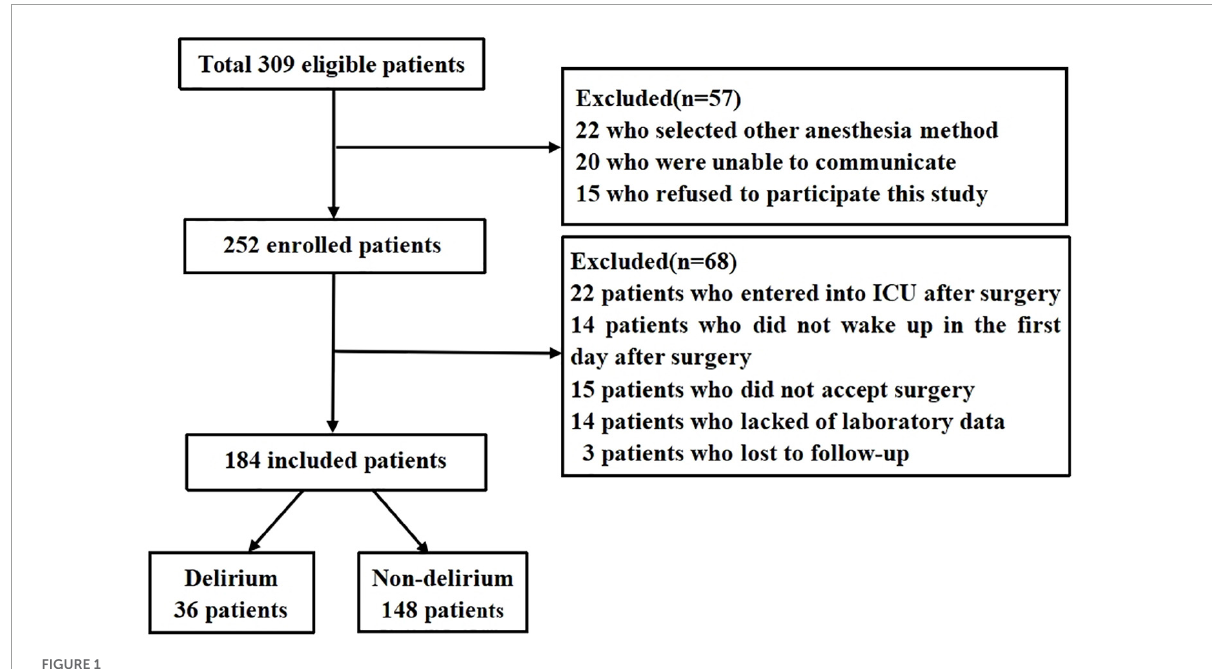
FIGURE1 Flow chart of study